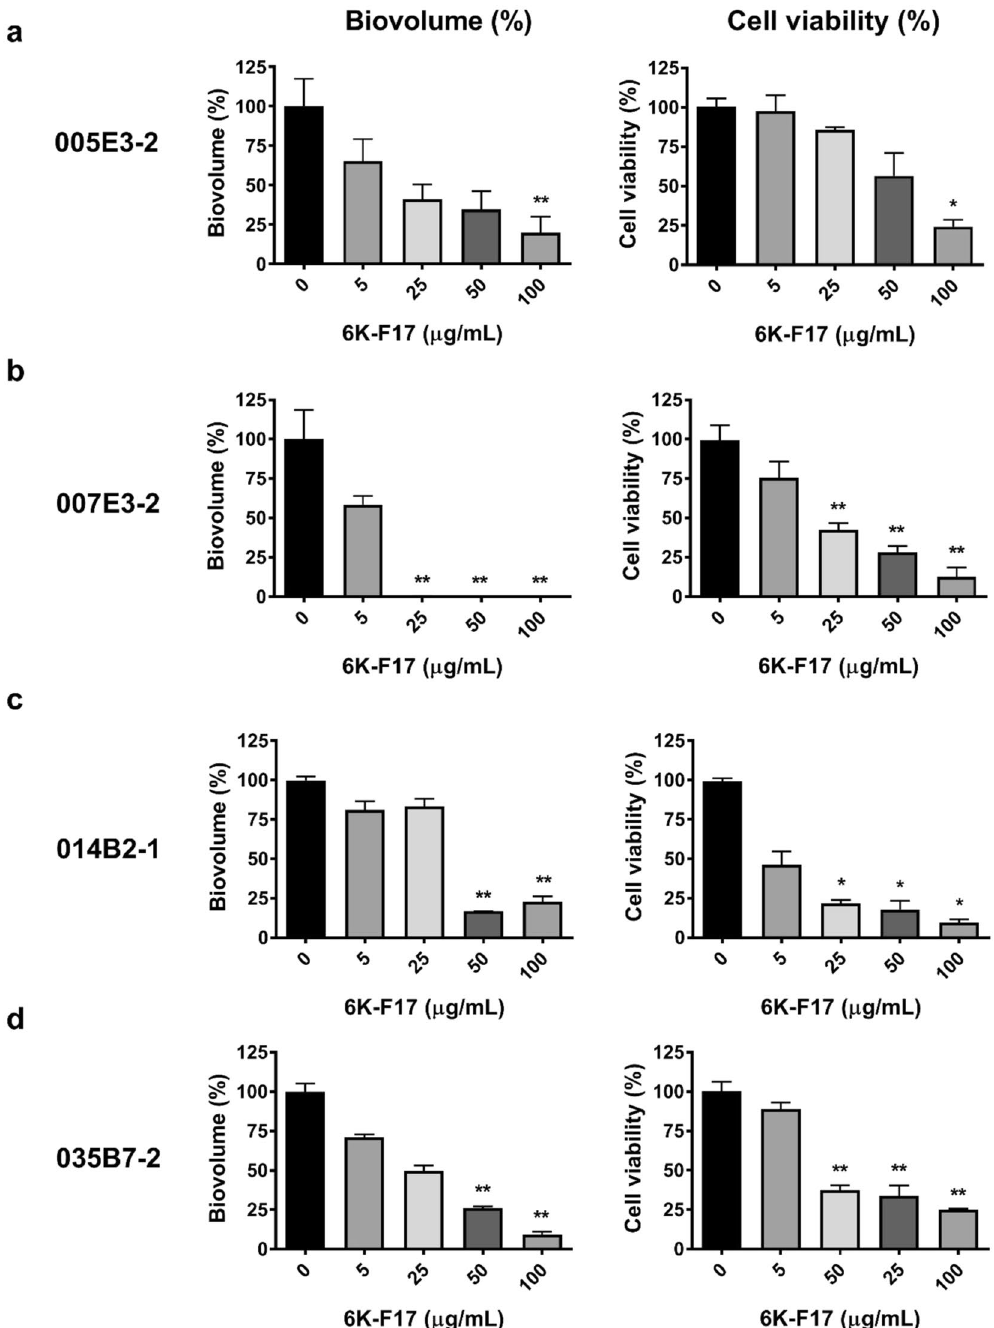
Figure 6. Cationic peptide 6K-F17 kills of multidrug resistant clinical isolates of P. aeruginosa biofilms. ( a – d ) Four multidrug resistant clinical P. aeruginosa isolates from chronically infected CF patients, were grown on a slide chamber in LB media for 30 hours prior to exposure with 6K-F17 for 16 hours prior to staining and confocal imaging. Left panels illustrate the biovolume as a percent of the untreated control. The mean of n = 12 images from N = 4 biological experiments is plotted and compared between conditions using a Kruskal-Wallis test with a Dunn’s multiple comparison post-test. Right panels illustrate the ATP bacterial viability assay (mean of n = 4 experiments). Comparison of means between the two conditions was done using a Mann-Whitney U test, ** p < 0.01. Error is reported as standard error of the